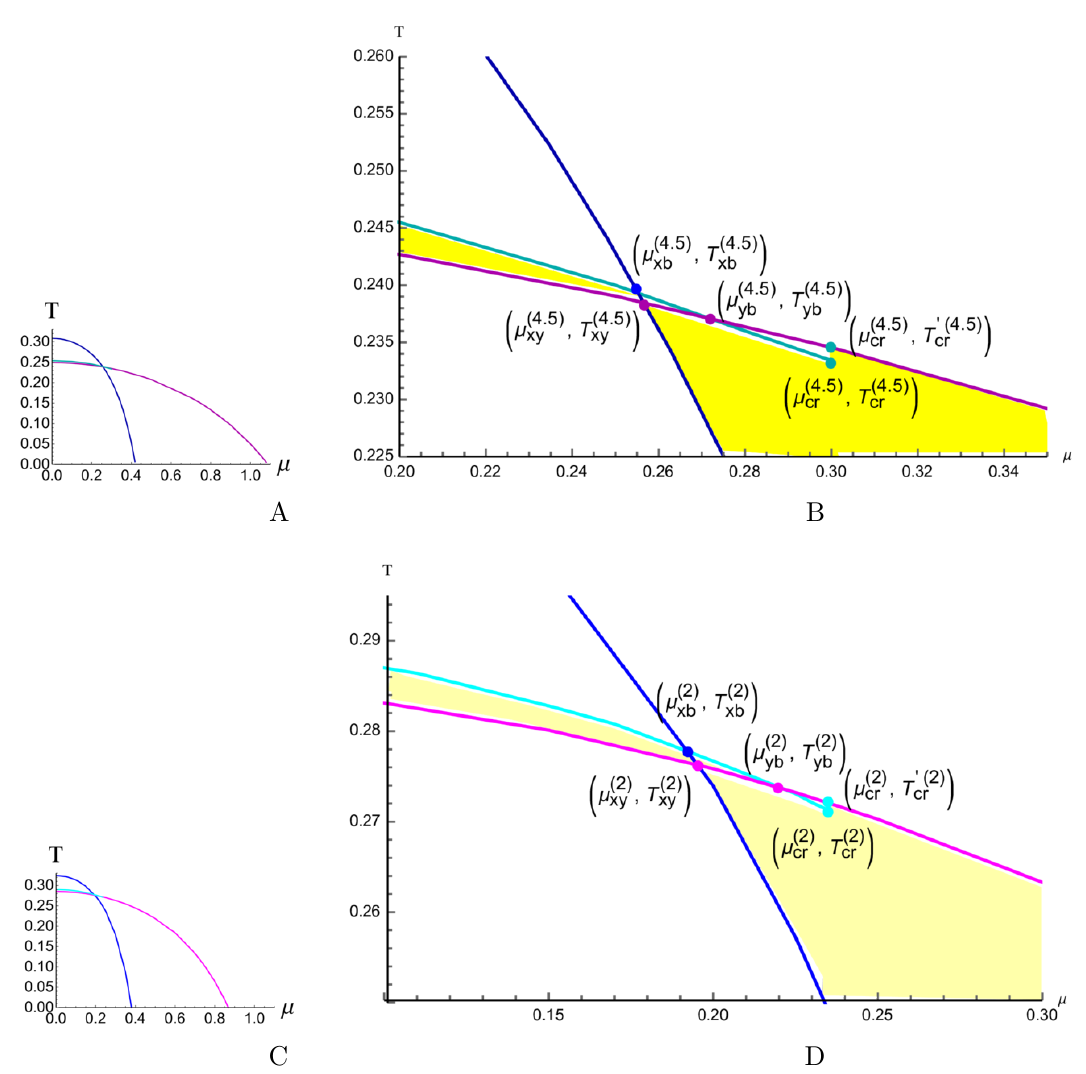
Figure 43 . Con(cid:12)nement-decon(cid:12)nement phase transition in the anisotropic case, (cid:23) = 4 : 5, c = (cid:0) 1, for the Wilson line W x (blue), the Wilson line W y (magenta) and the background (cyan) (A). Plot (B) is a zoom of (A) near the critical points ( (cid:22) xb ; T xb ), ( (cid:22) yb ; T yb ) and FOPT ( (cid:22) b ; T b ) ! ( (cid:22) b ; T 0 Plots (C) and (D) are the analogues of (A) and (B) for (cid:23) =